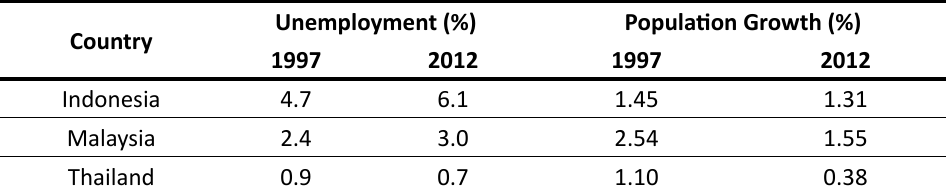
Table 1: Number of Unemployed and Growth of Population in 5 Countries ASEAN Year 1997 –